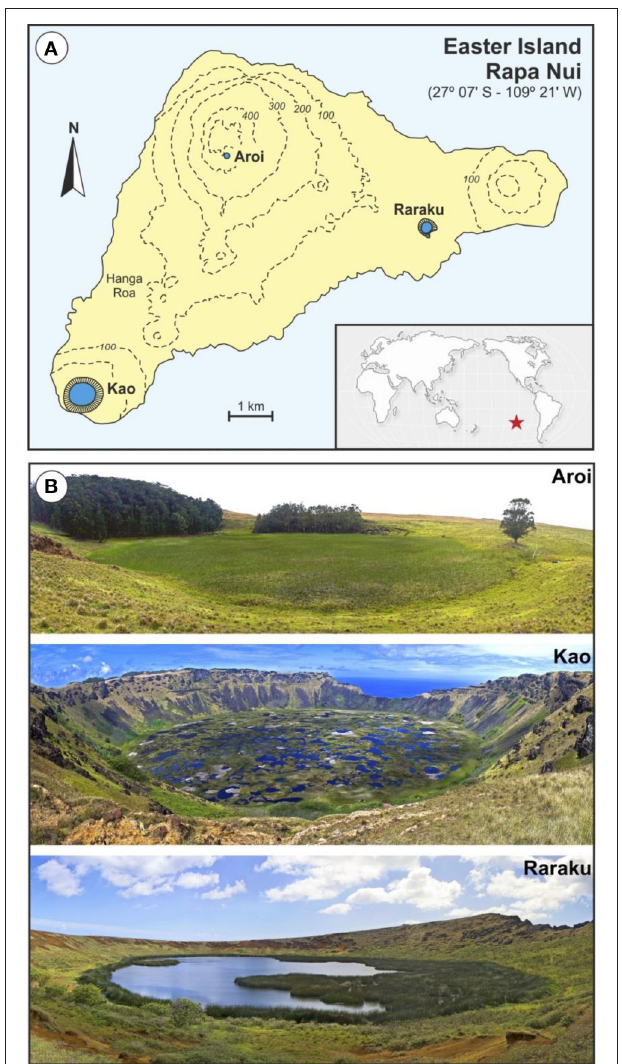
FIGURE 1 | Location map and cored lakes. (A) Sketch map of Easter Island showing the location of the three freshwater bodies cored for paleoecological studies (Aroi, Kao and Raraku). The position of the island in the Pacific Ocean is indicated by a red star. (B) Permanent freshwater lakes and mires from Easter Island (Photos: V.